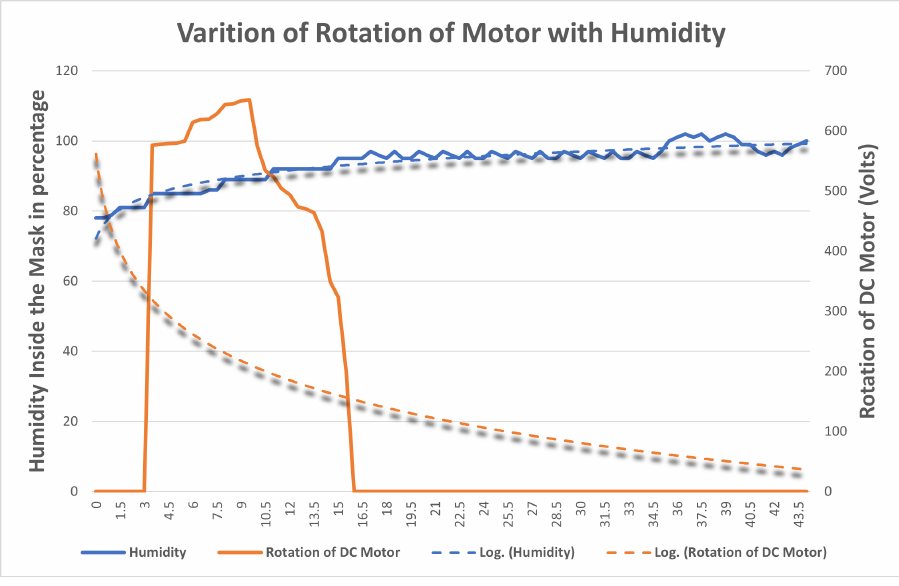
Figure 20. Variation of rotation of motor with humidity inside the mask.